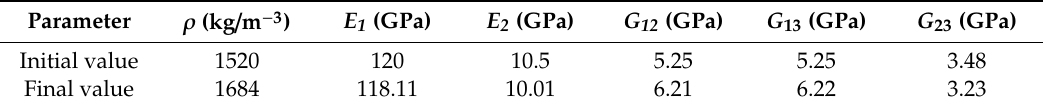
Table 6. The initial and final values of material parameters.